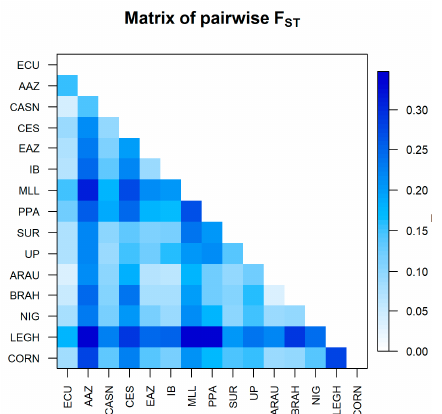
Figure 2. Pairwise fixation index of subpopulation total (FST) distance matrix. ECU: Ecuadorian Creole